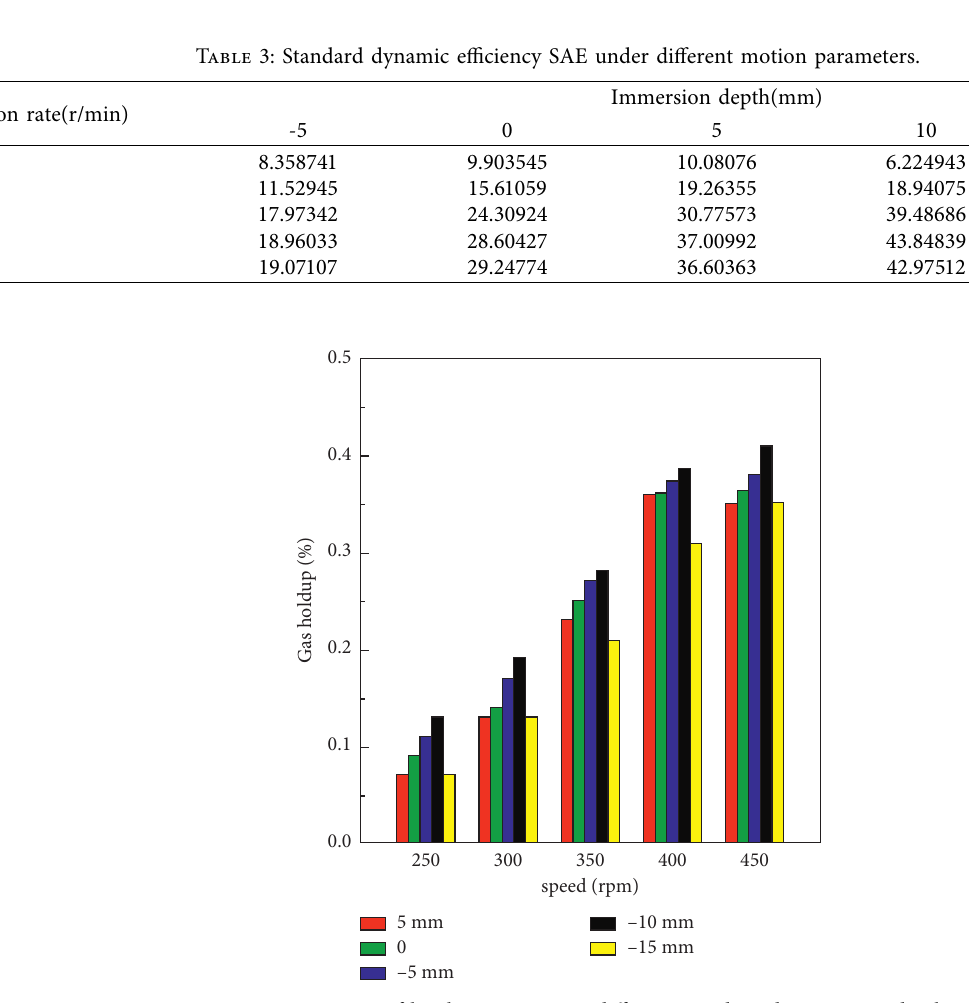
Figure 20: Comparison of local gas content at different speeds and immersion depths.